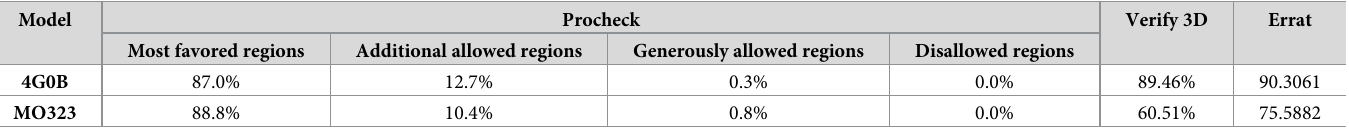
Table 3. Related parameters for confirmation of the simulated structure and its similarity to the pattern. Model Procheck Verify 3D Errat Most favored regions Additional allowed regions Generously allowed